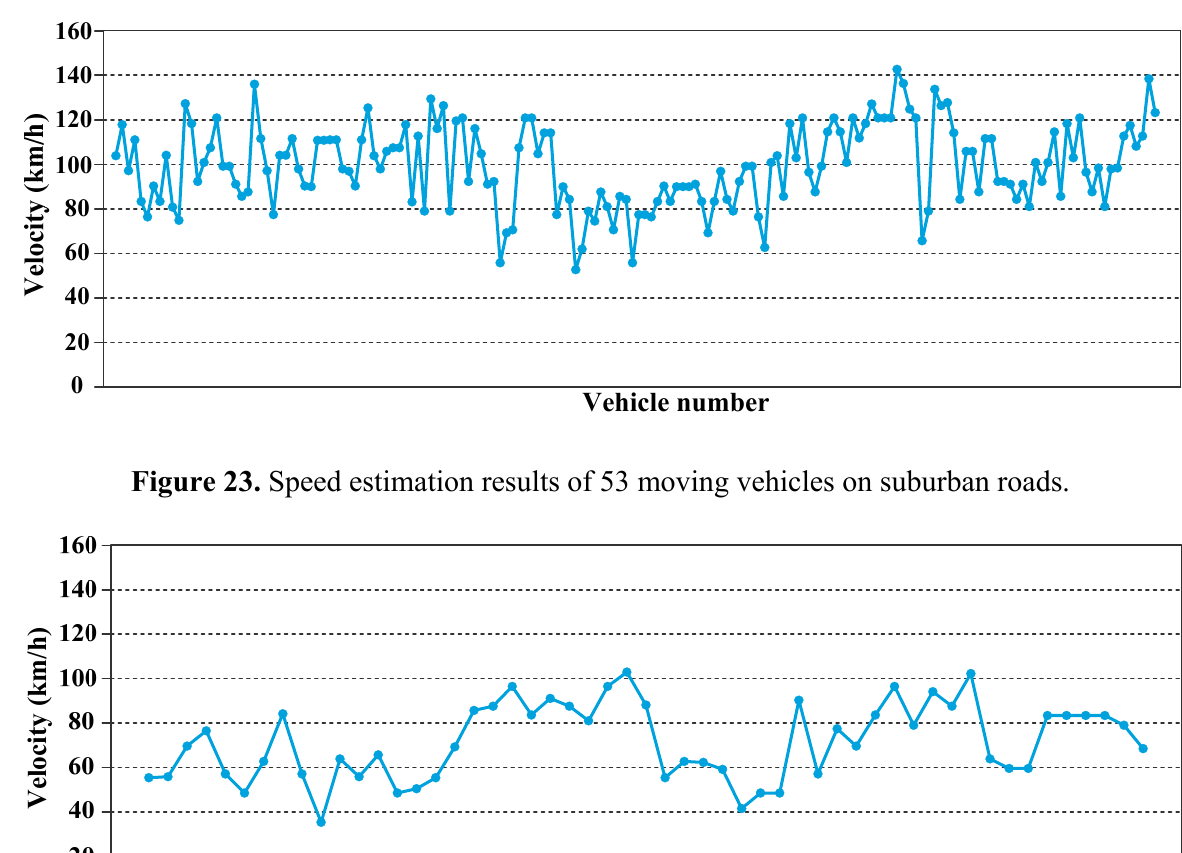
Figure 22. Speed estimation results of 166 moving vehicles on highways.